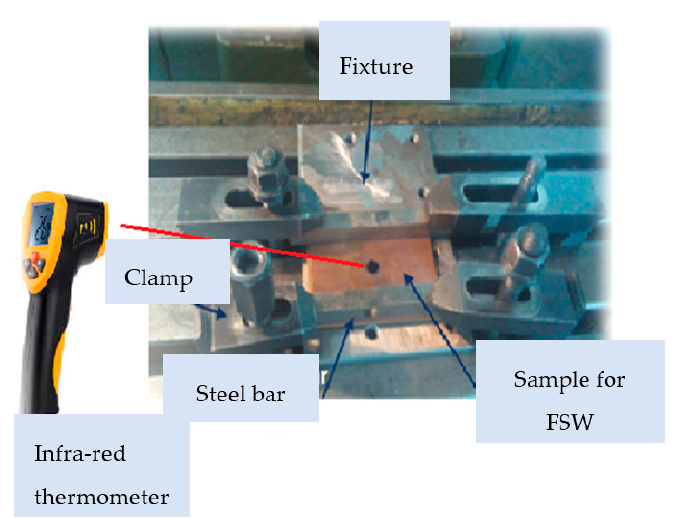
Figure 3. Schematics of friction stir welding (FSW) lap sample.